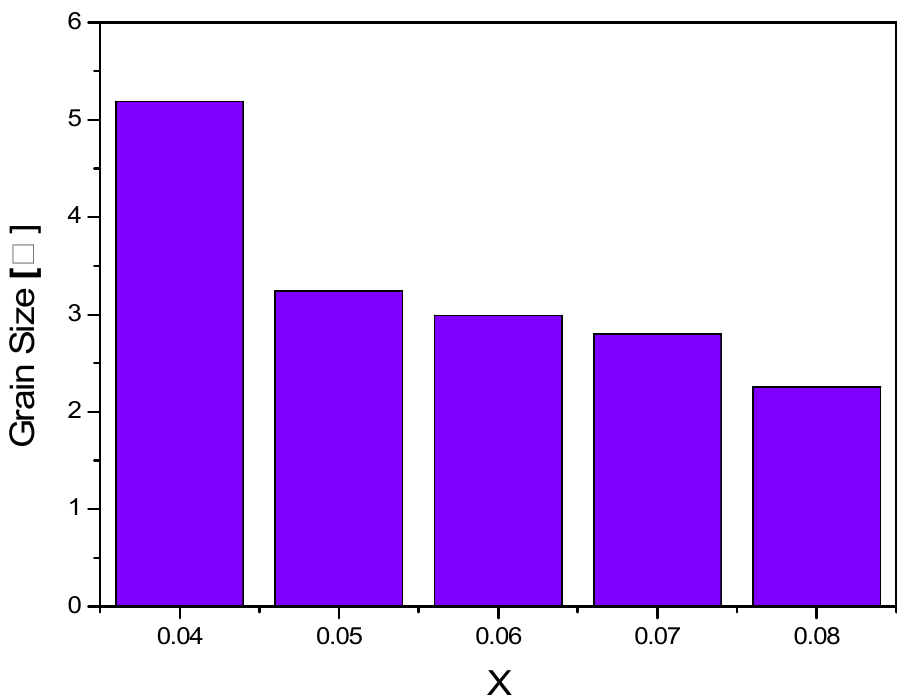
Figure 2. Grain size of samples with the amount of antimony. The X-ray diffraction (XRD) pattern with the antimony of samples fired at 1060 ◦ C for 10 h are shown in Figure 3. All off the samples exhibit pure perovskite phase, and no secondary phases were investigated. The ceramic samples from x = 0.04 to x = 0.07 possess coexistence of a rombohedral-tetragonal (R-T) shape, which is indicated by the tetragonal (002) and (200), along with the rhombohedral (200) peak, as shown in Figure 3b. Here, the intensity of the tetragonal (002) peak was slowly weakened, and the rhombohedral (200) peak evidently appeared in association with the increase in antimony substitution. When x = 0.07, the piezoelectricity of the samples was greatly enhanced due to the increase of the coexistence ratio of a rombohedral-tetragonal (R-T)